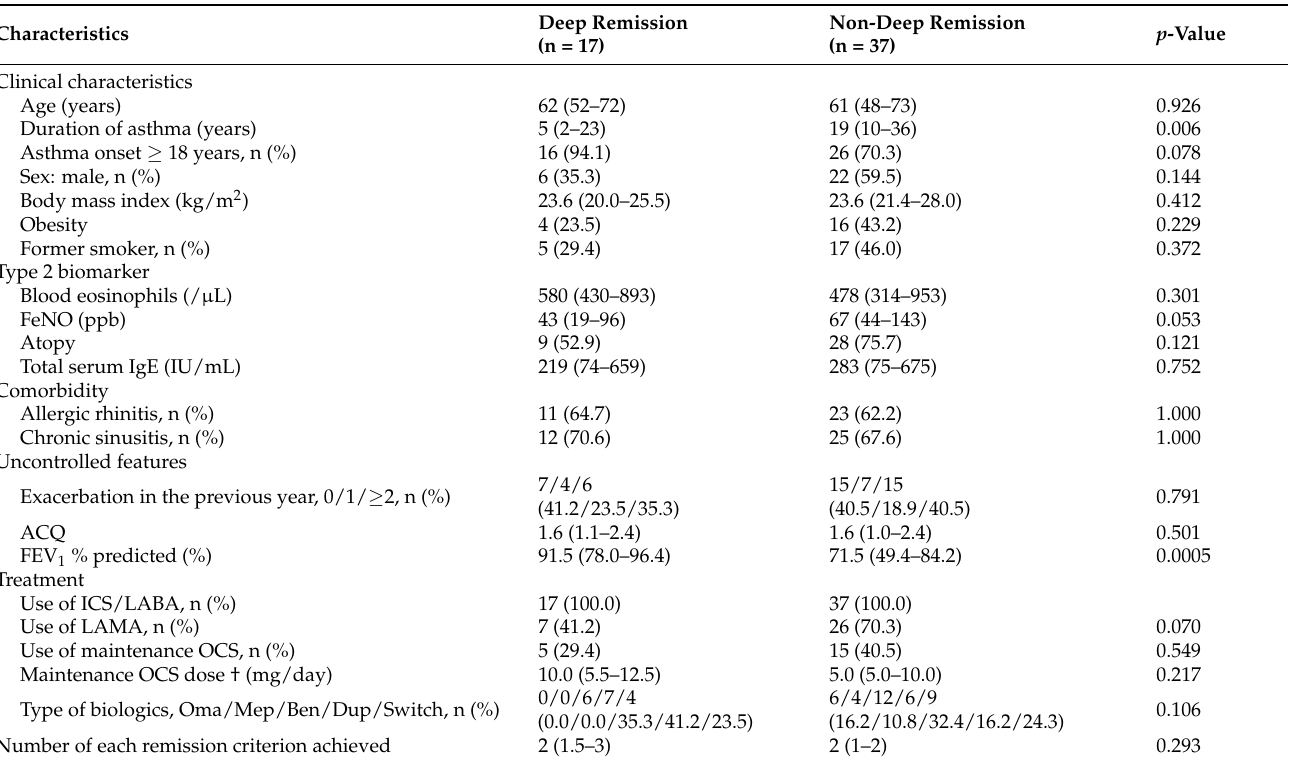
Table 3. Comparison of patient characteristics between the deep remission and non-deep remis- sion groups.